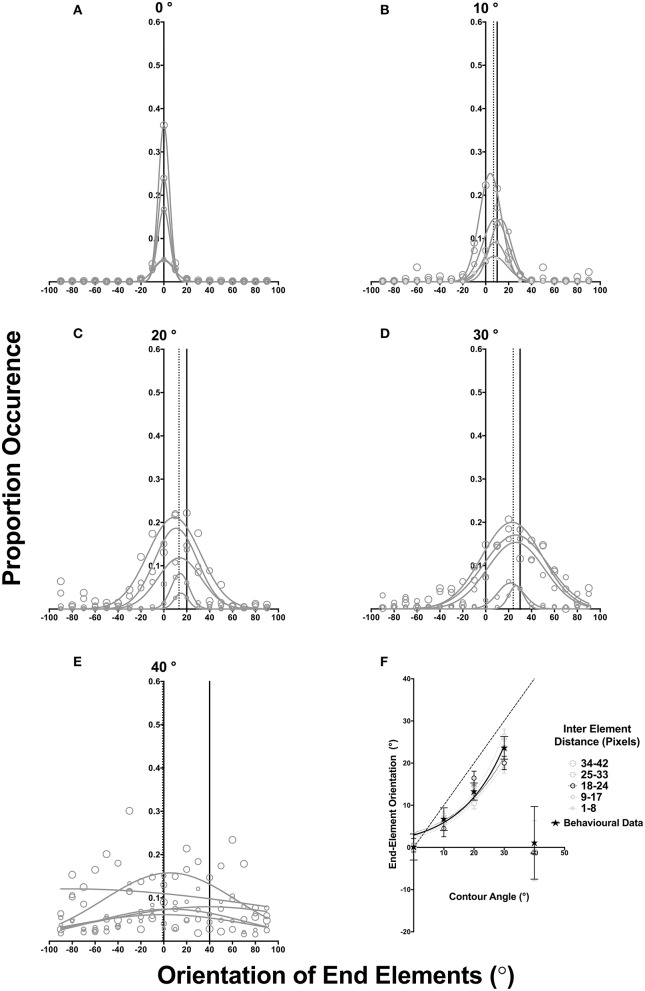
(A–E) plots normalized proportion of occurrence for different end-element orientations. Solid and dotted vertical lines indicate the contour angle and the mean peak of the Gaussian fits averaged across all five inter element distance bins. In (F) the peak end-element orientation is plotted as a function of the contour angle for our behavioral data (star) and the outcomes of our image analysis; error bars represent SD of the Gaussian fit. Different contour lengths are given by different sized circles (see legend). Dotted lines represent the best exponential fit, while the dashed diagonal line indicates a one to one match between the contour angle and the orientation of end elements.